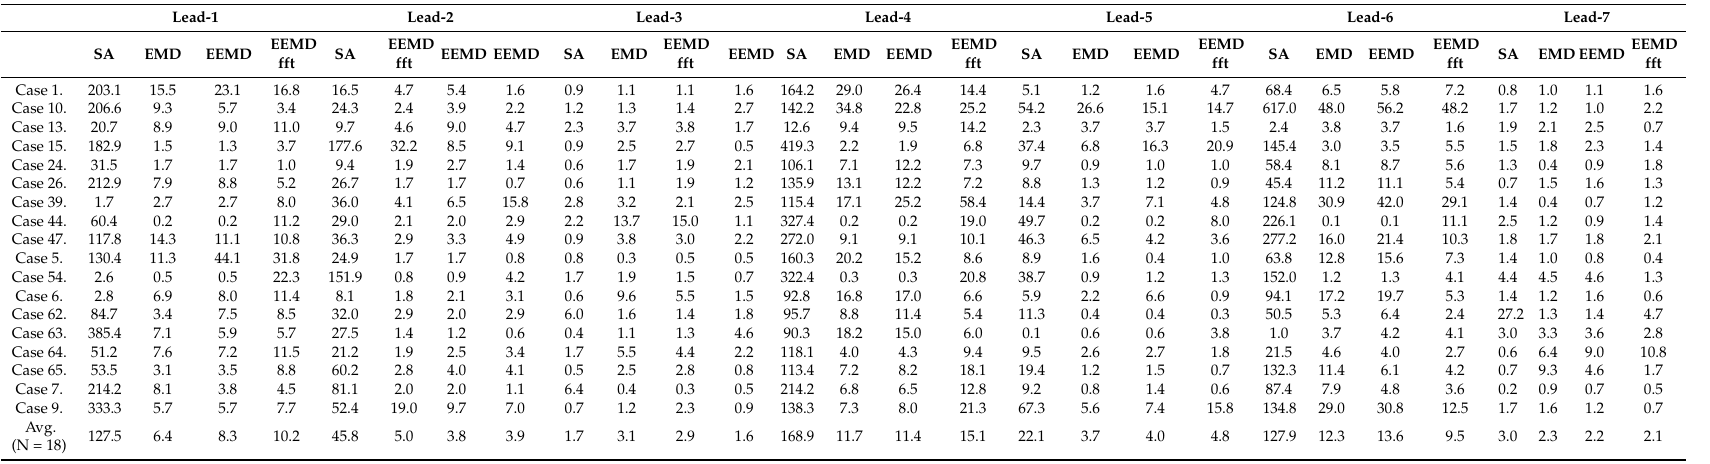
Table 3. Results of the SNR values in selected best cases (‘Golden Cases’, N = 18) of arm-ECG bipolar lead set recordings, for the different data-driven denoising methods (EMD, EEMD and EEMD-fft) and for the control SA method as an indication of signal quality. Lead-1 Lead-2